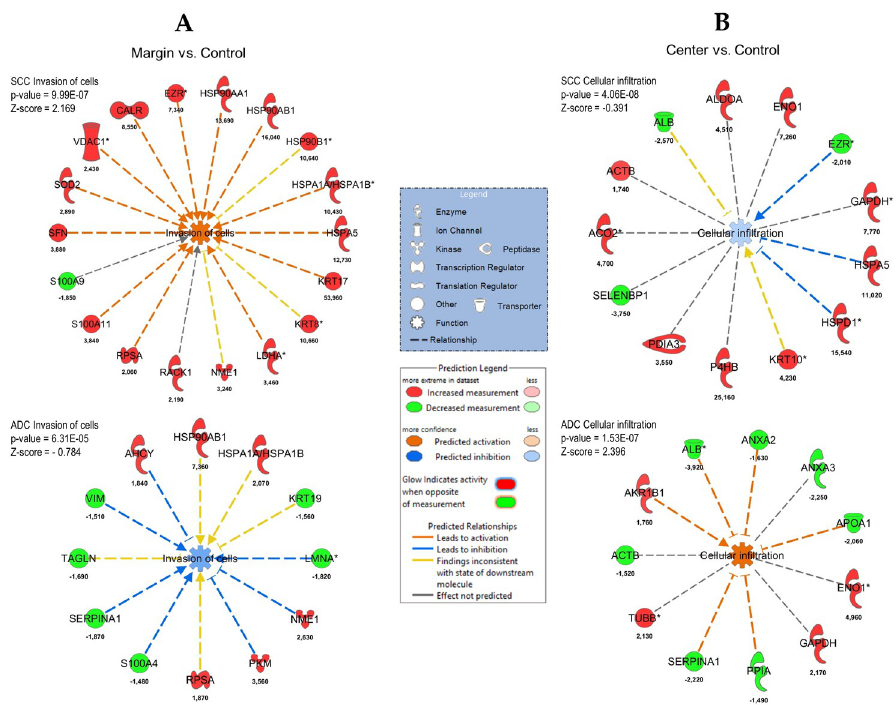
Fig 9. Invasion of cells and cellular infiltration functions overlaid with proteins from the particular comparison for SCC and ADC. (A) margin vs. control; (B) center vs. control. Each network shows the proteins in the particular analysis that have a causal or correlative relationship with the function and indicates how they might increase or decrease selected function. Legends are a graphical explanation of icons, lines and colors used in a graph. Difference in protein abundance is indicated below each